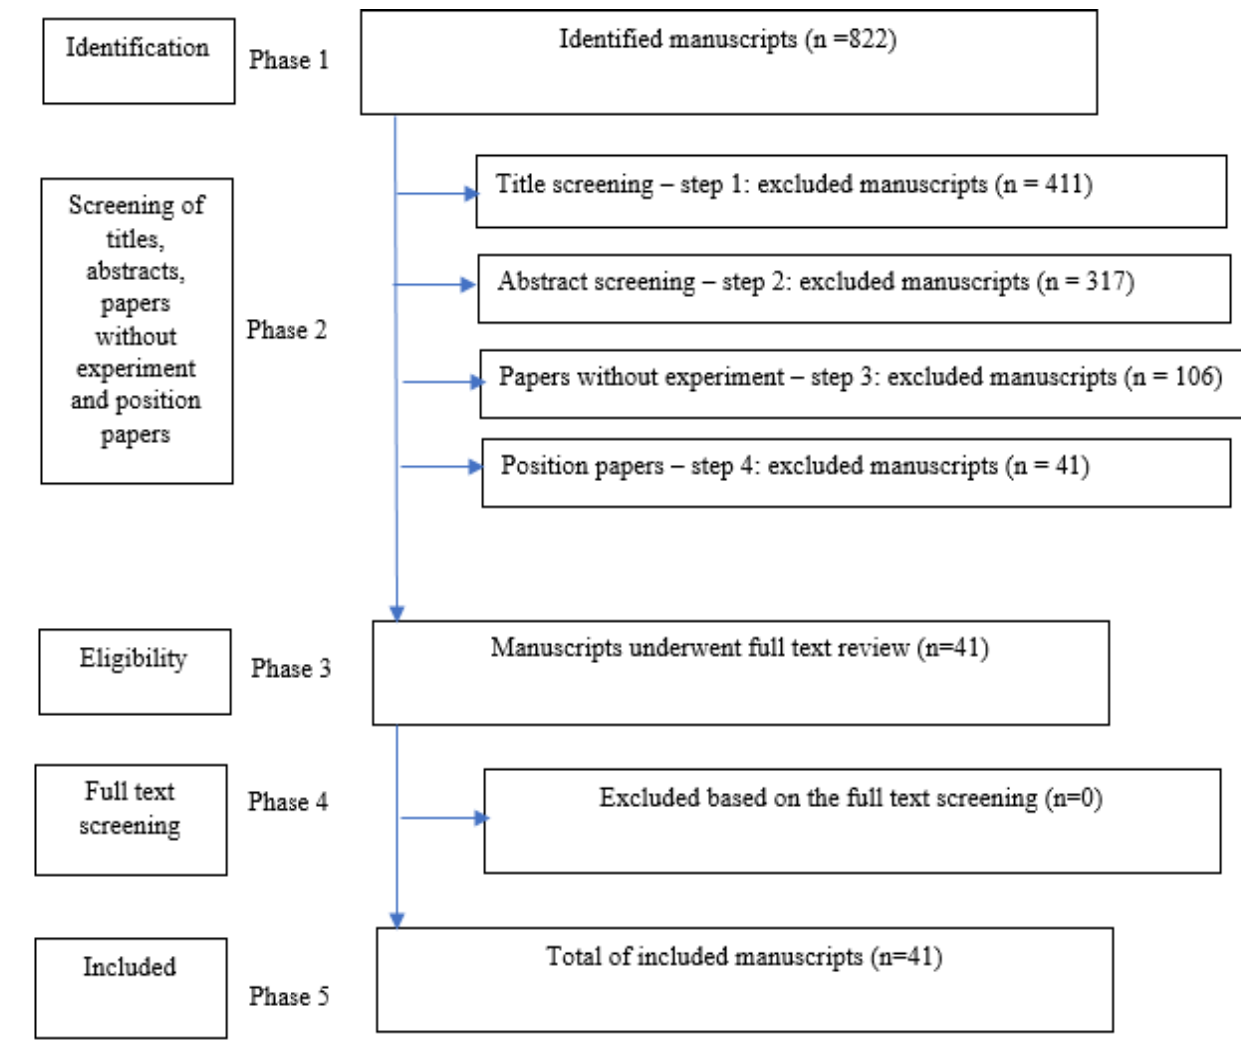
Figure 3. PRISMA flow chart.